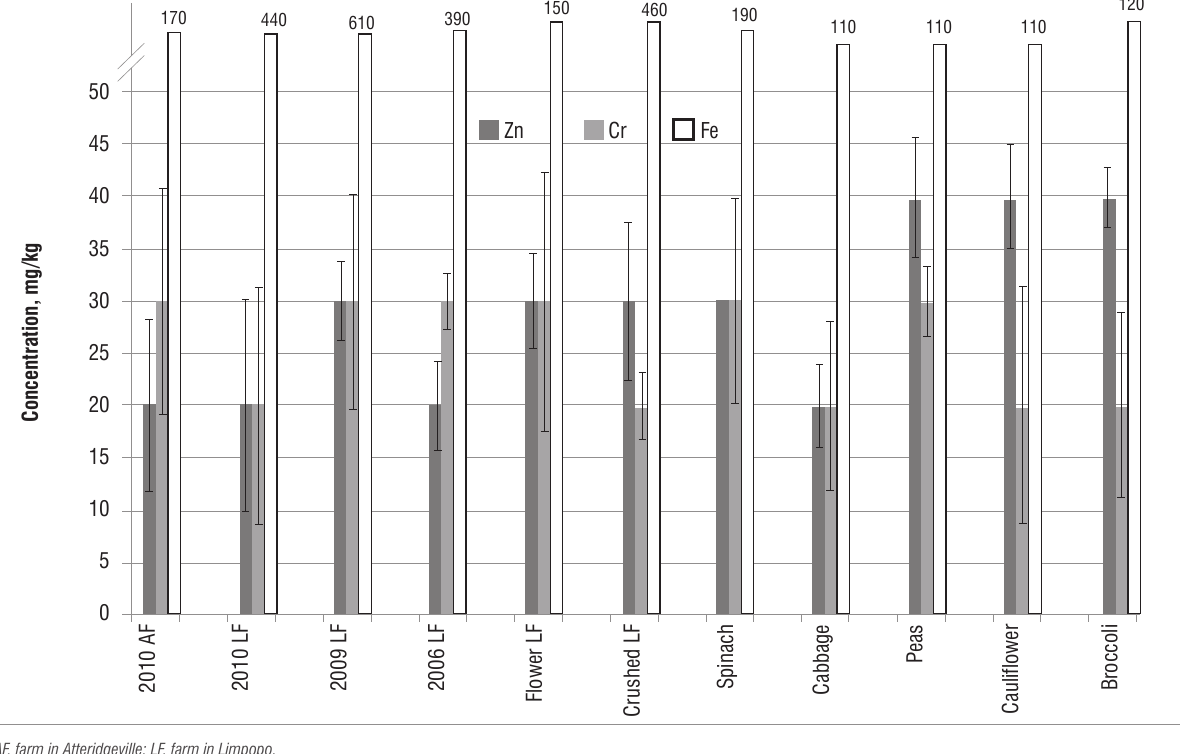
AF, farm in Atteridgeville; LF, farm in Limpopo. Crushed LF refers to moringa leaves which were purchased in packets. Values above the bars indicate the concentration of Fe. Figure 6: Concentration of trace nutrient elements in moringa and selected vegetables. Results shown are means of triplicates; error bars represent %RSD